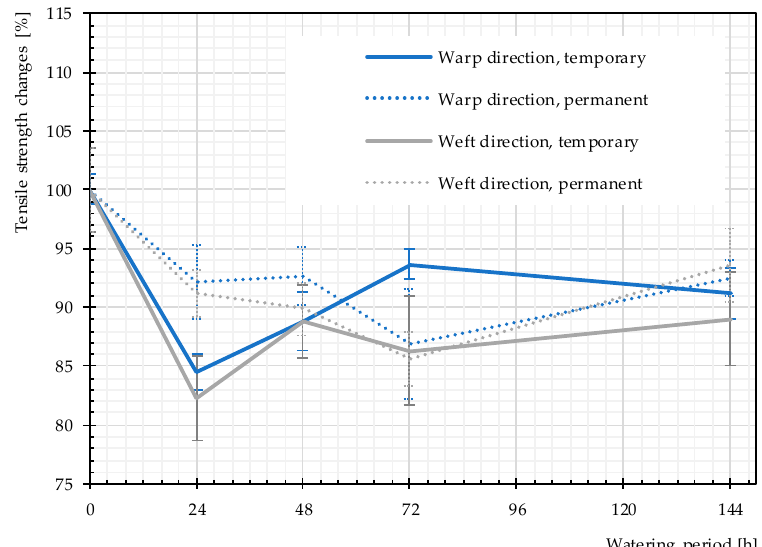
Figure 12. Temporary and permanent changes of the tensile strength, glass-PTFE type II first batch according to Table 3. Continuous lines: temporary changes, dashed lines: permanent changes. Table 5. Magnitude of the tensile strength recovery and permanent residual tensile strength for glass-PTFE type II according to Table 3 after different watering time periods.